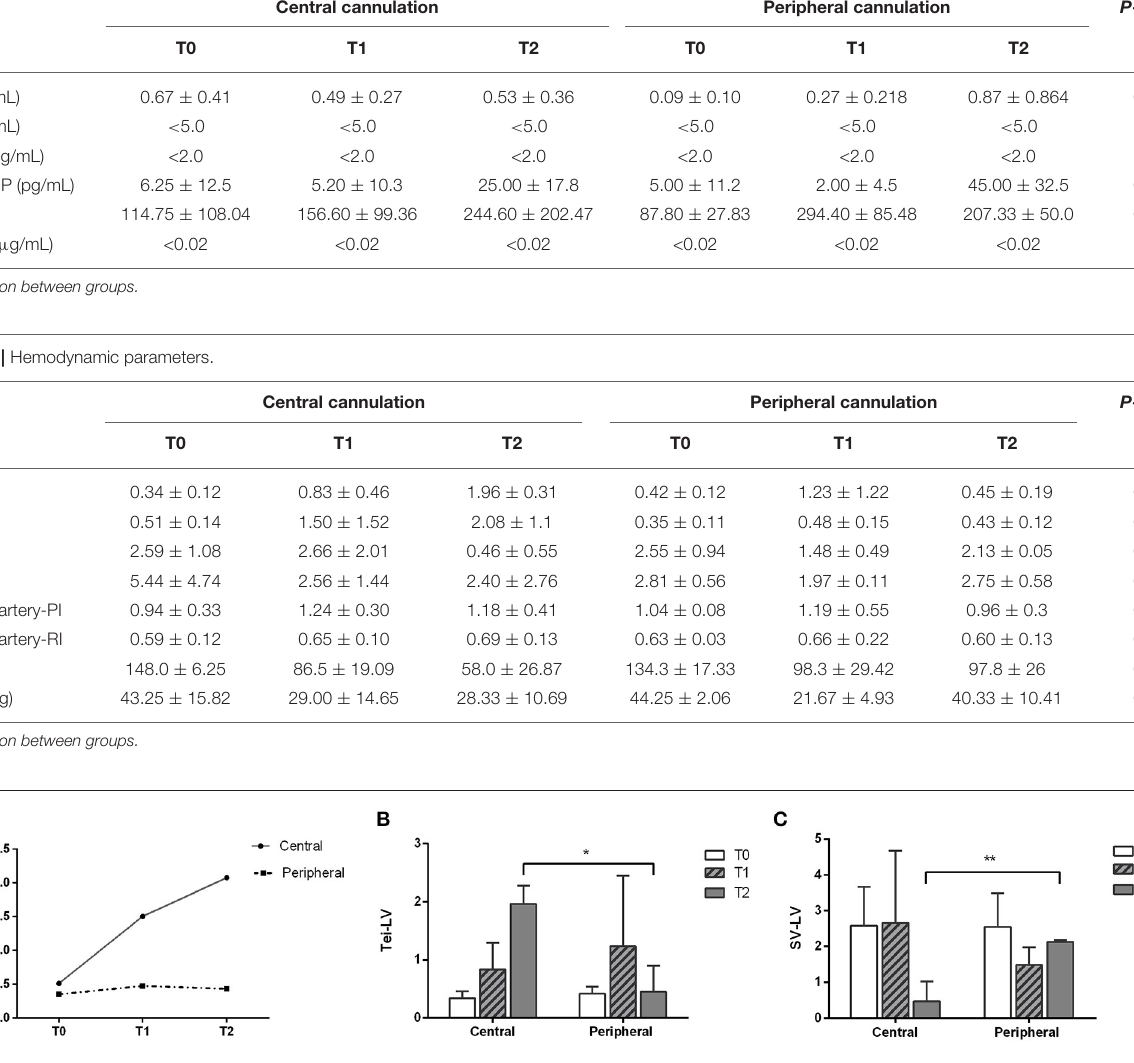
FIGURE 2 | Changes in right ventricular (A) and left ventricular (B) Tei index and left ventricular stroke volume (C) in the two cannulation groups revealed a greater impact of central cannulation on ventricular function (* p < 0.05, ** p < 0.01).